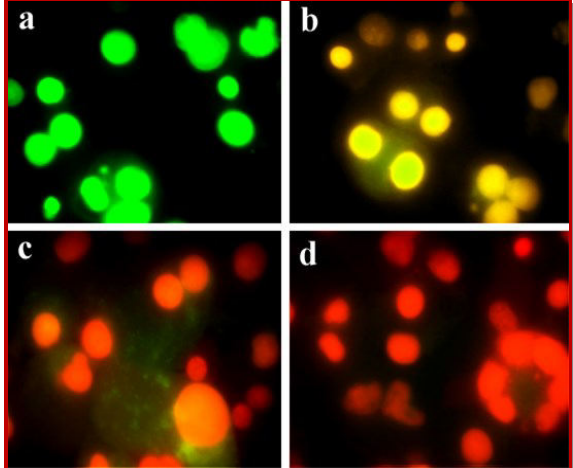
Figure 4: Fluorescent microscopic analysis of MCF-7 cells treat- ed with ethyl acetate extract of O. stamineus leaves; a) Control, b) 10 μ g/mL; c) 20 μ g/mL; d) 40 μ